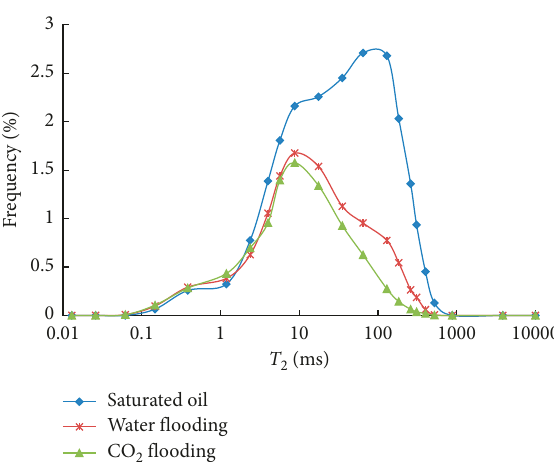
Figure 5: Distribution of residual oil with T